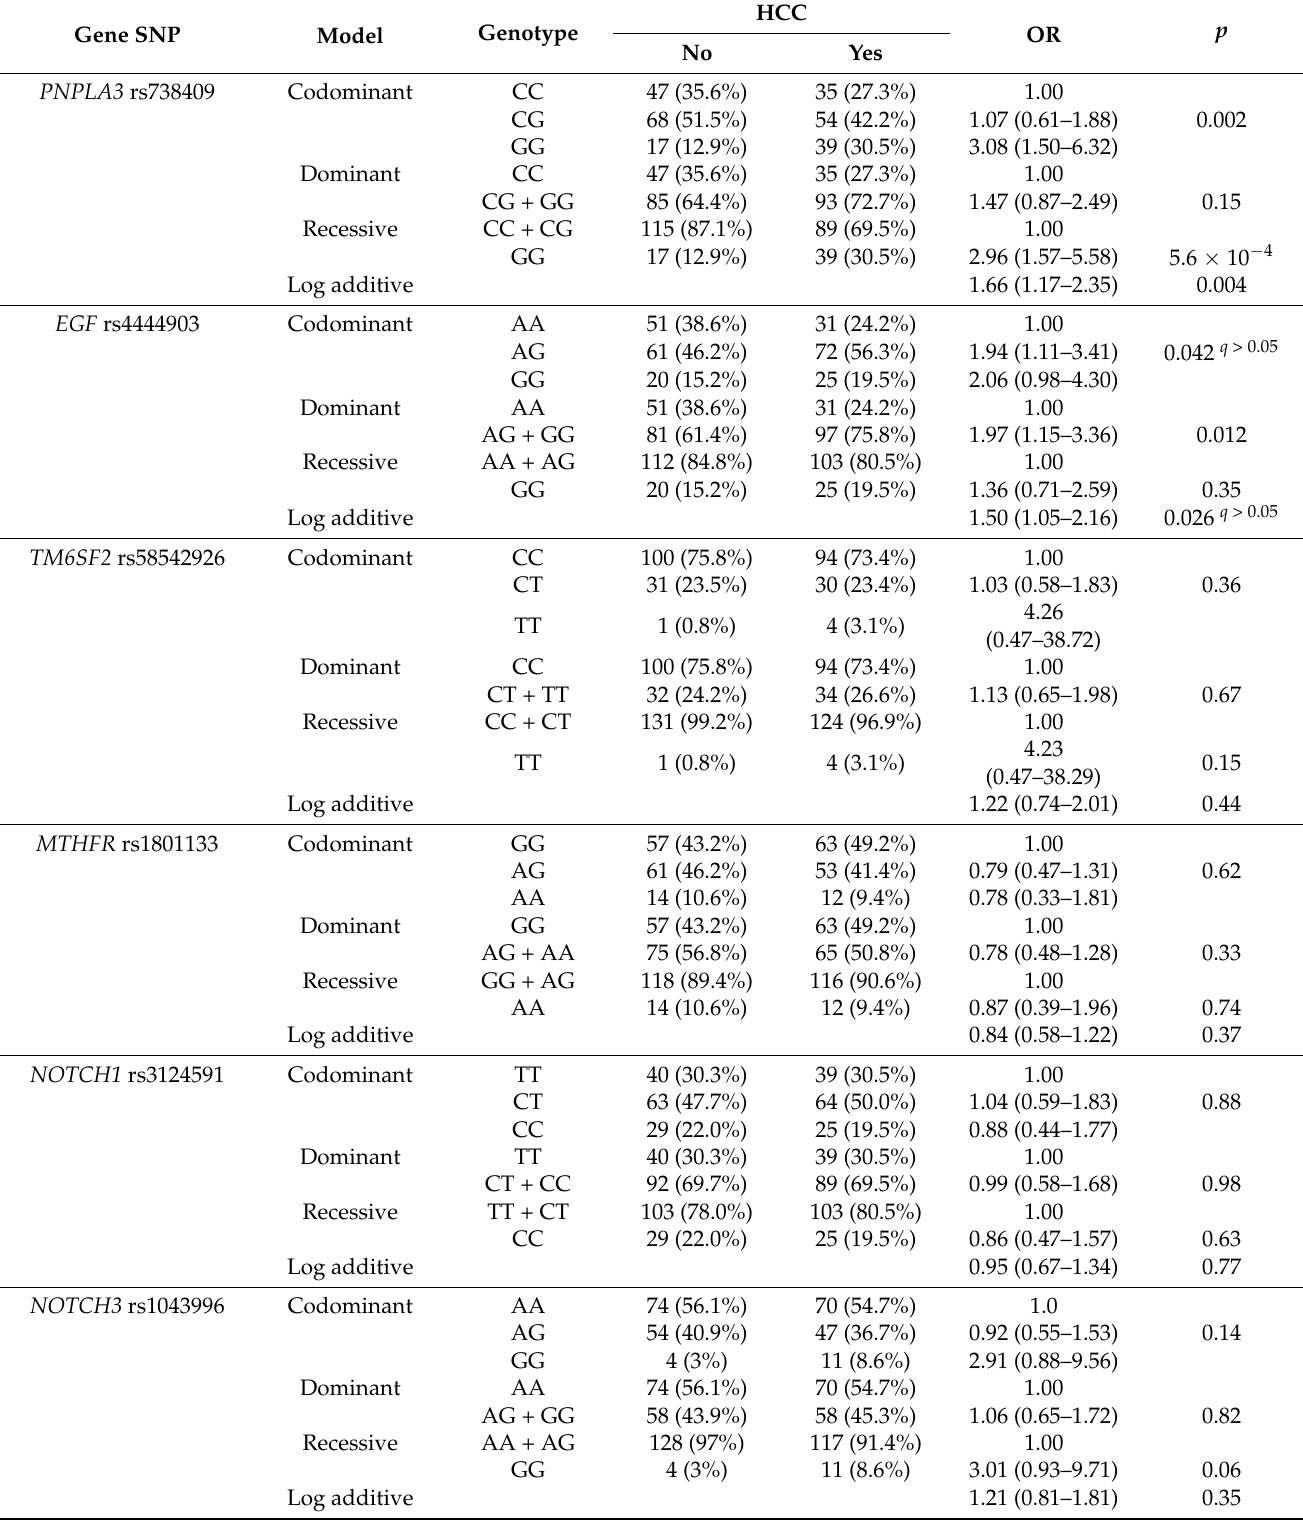
Table 4. Single-nucleotide polymorphism-associated odds ratio for HCC